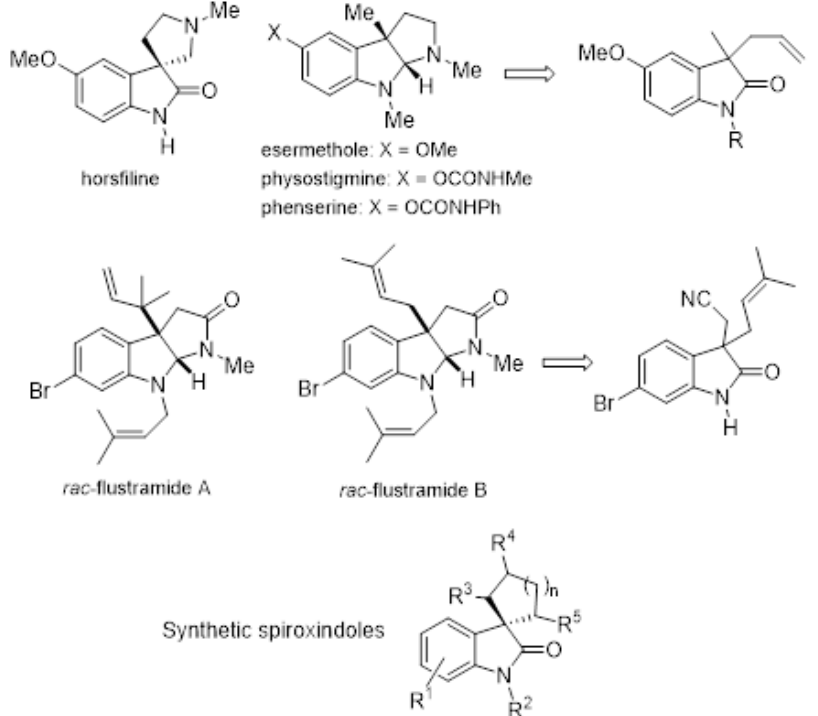
Figure 1 - Natural and synthetic biologically active compounds containing the 2-oxindole unit.